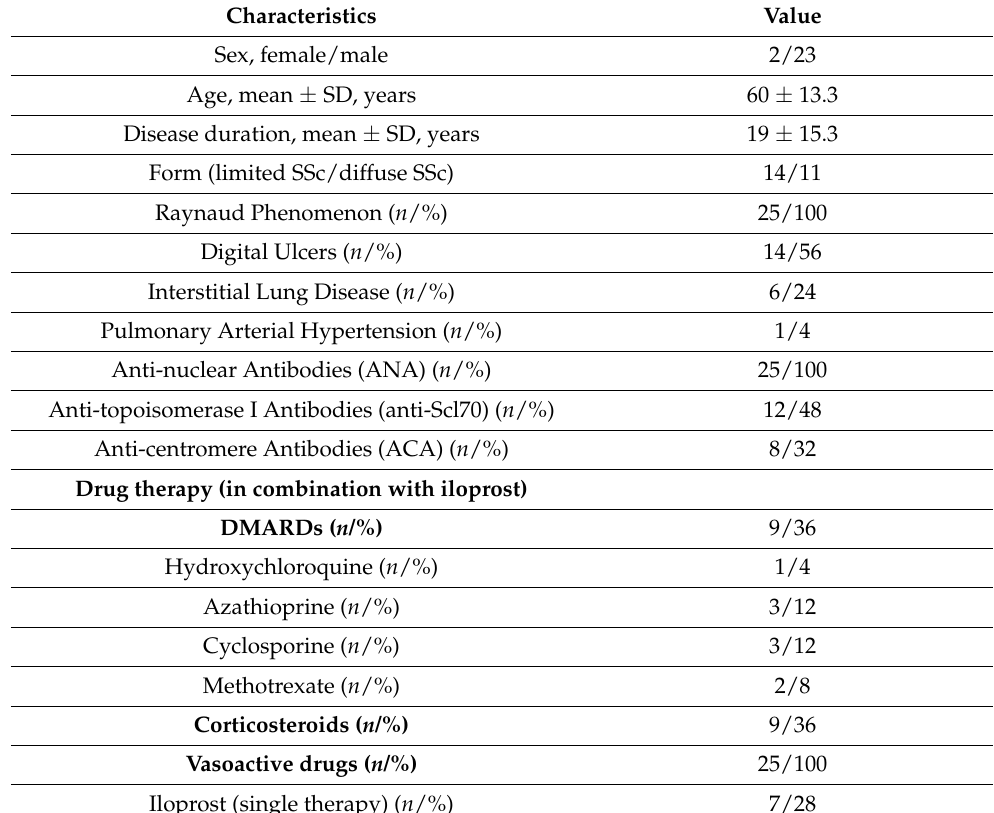
Table 1. Demographic, clinical, and therapeutic characteristics of SSc patients ( n = 25) under iloprost